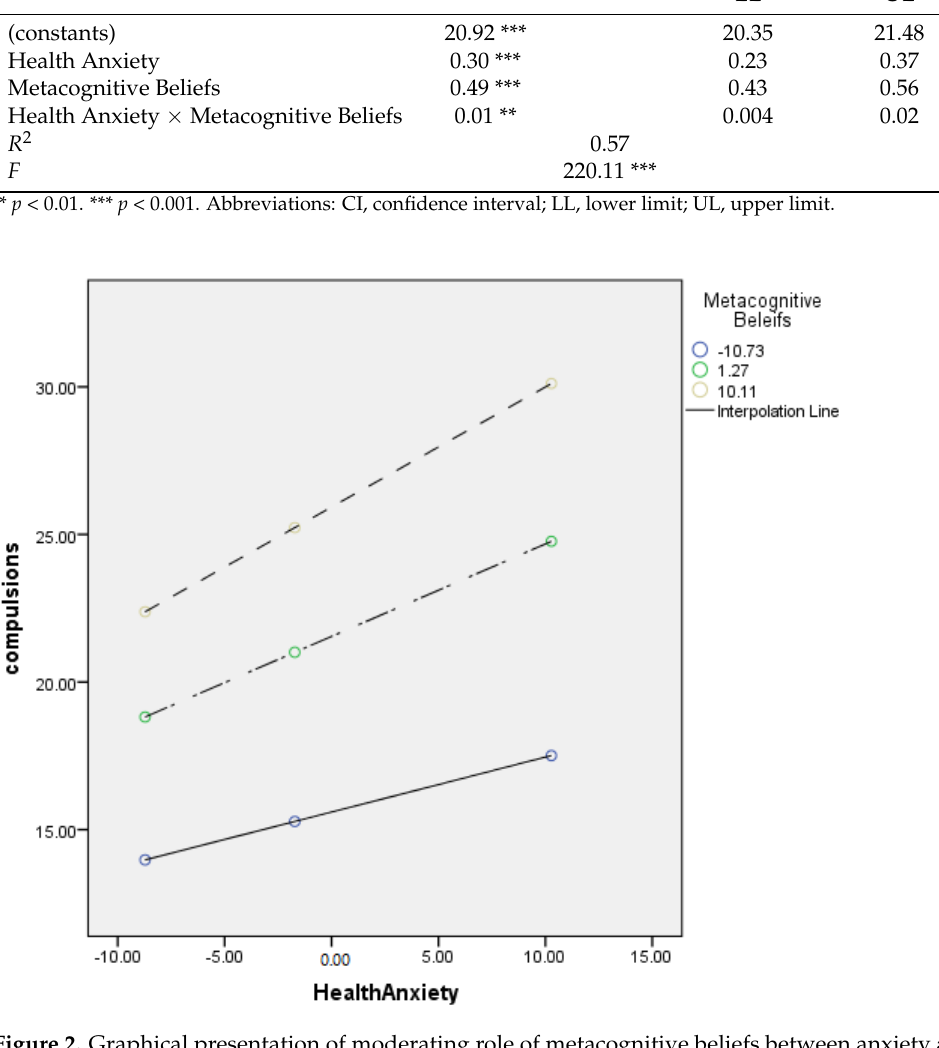
Figure 2 . Graphical presentation of moderating role of metacognitive beliefs between anxiety and